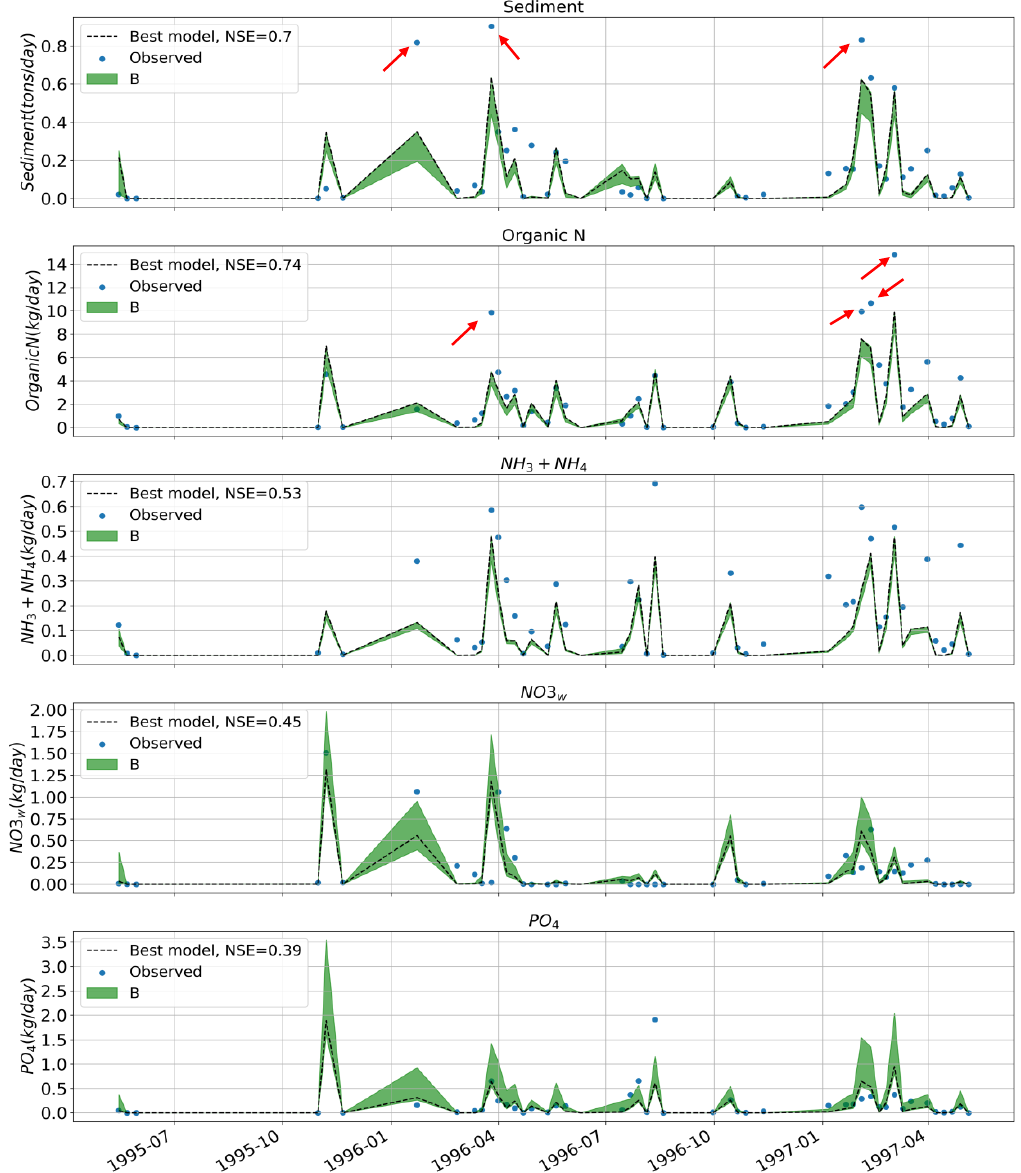
Figure 7. Model uncertainty bands for behavioral simulations in comparison with best simulation (highest NSE) and weekly observed loadings for sediment, ON, (NH 3 + NH 4 )-N, NO 3 and PO 4.